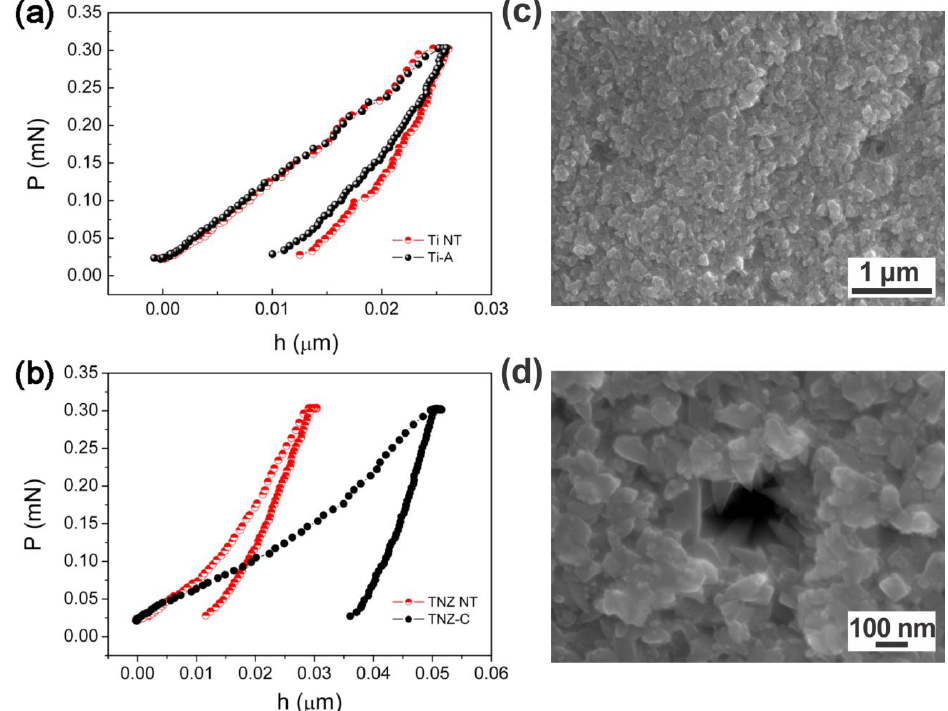
Figure 4. Representative load-displacement (P-h) nano-indentation curves ( P of: ( a ) samples Ti NT and Ti-A; ( b ) TNZ NT and TNZ-C; ( c ), ( d ) SEM images at different magnifications of the indent for sample